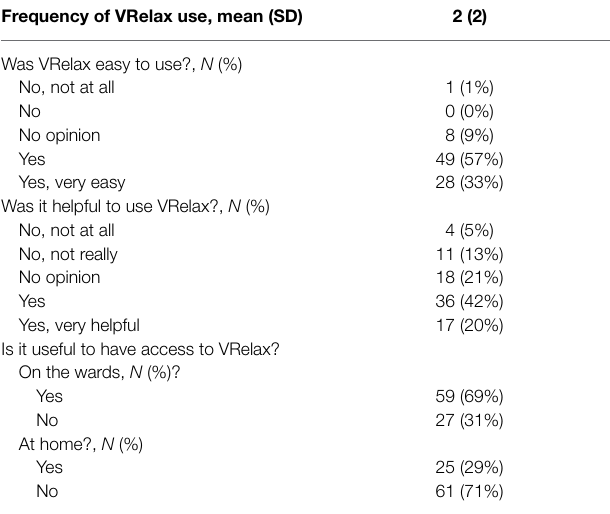
TABLE 3 | VRelax use: frequency and experiences of 86 ICU nurses. Frequency of VRelax use, mean (SD) 2